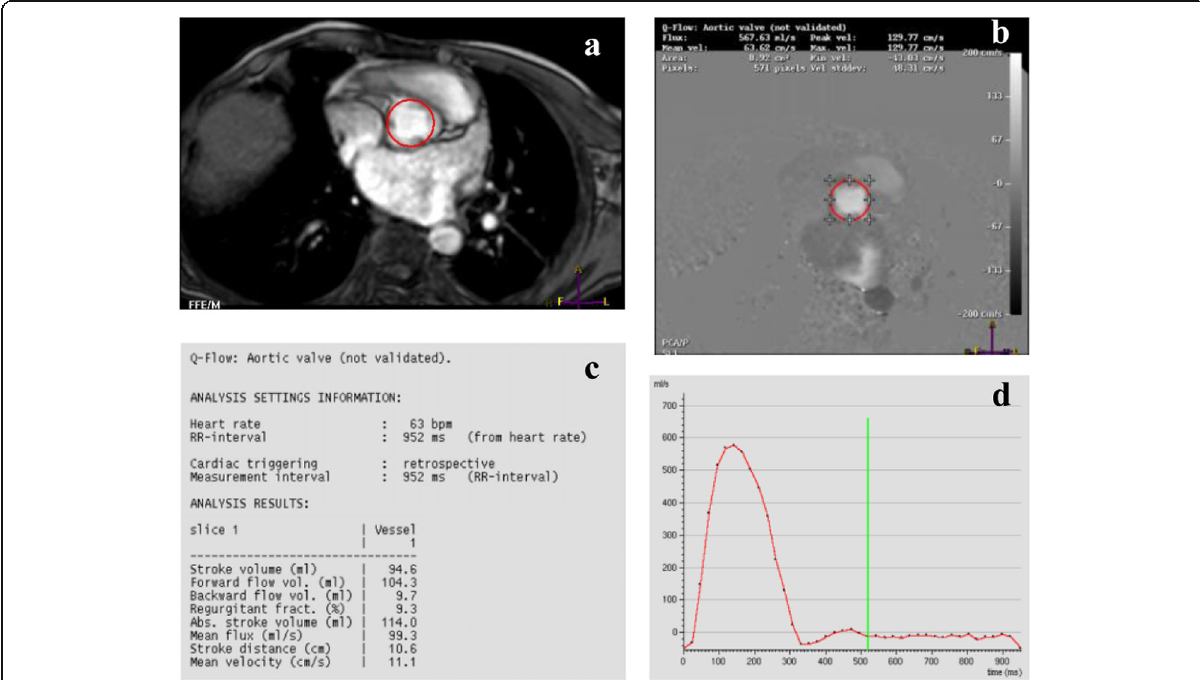
Fig. 5 On the other hand, the same patient using the phase-contrast analysis, the LV stroke volume (SVPC) was 94.6 ml and ejection fraction (EFPC) was (94.6/295.7) × 100 = 32% which reflects moderate dysfunction. a The magnitute image showing the detailed anatomy, contour, and the shape of the aortic valve during systole. b The phase velocity map depicts the velocity and direction of flow in each pixel within the aorta. c Q-flow analysis of the aortic flow. d By outlining the contours of the aorta throughout each phase in the cardiac cycle, a flow curve can be generated to determine aortic forward reverse stroke volume and